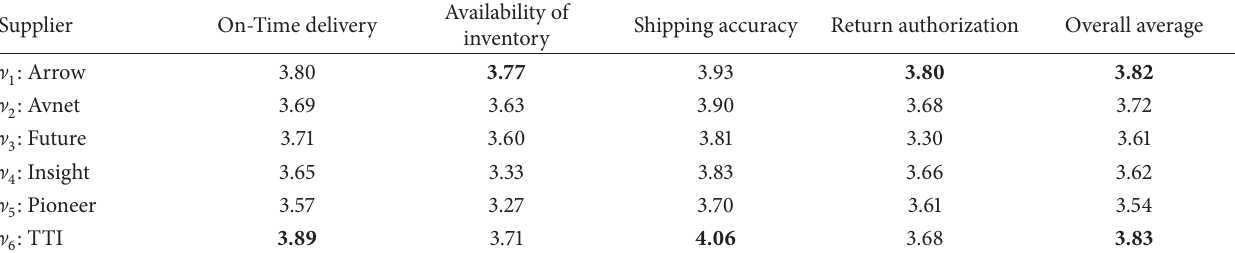
Table 2: Scores for all suppliers on all attributes of the delivery criterion.